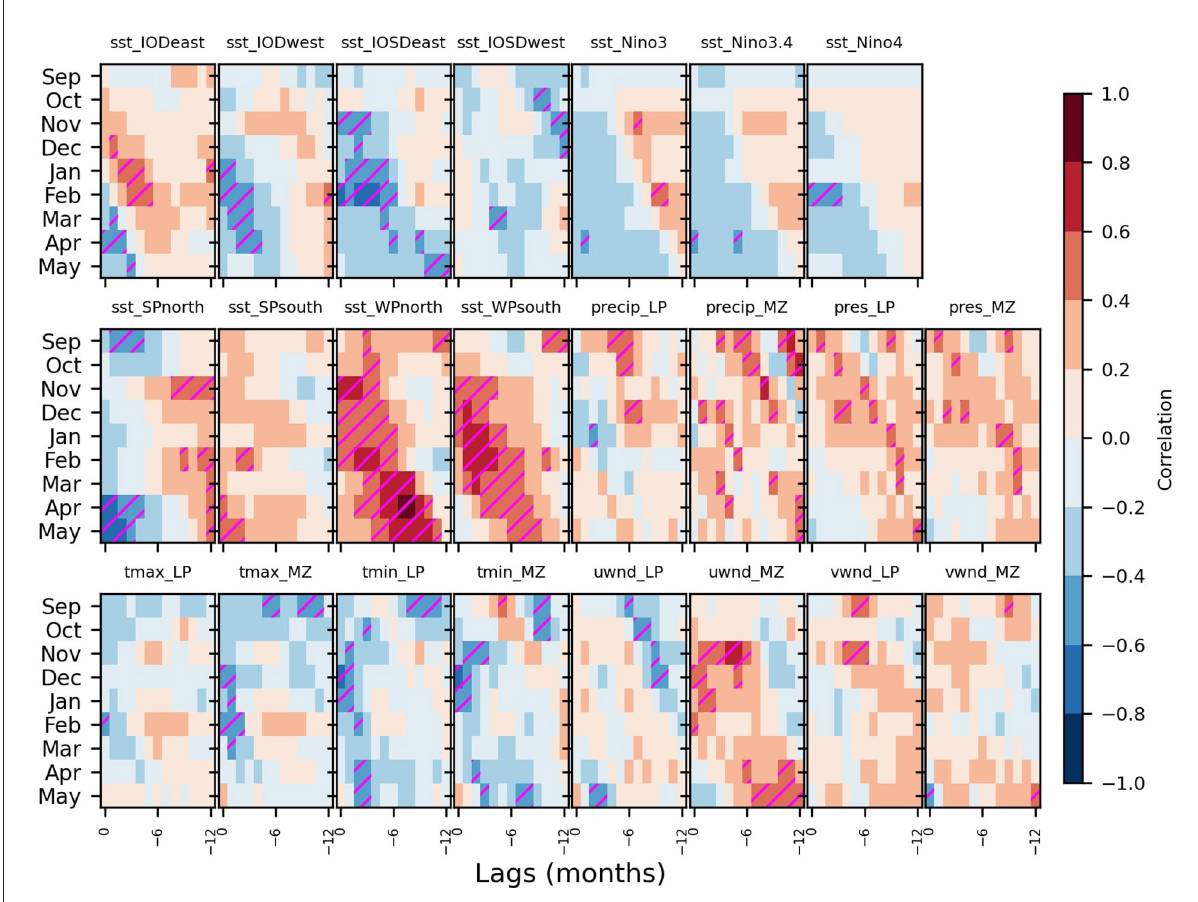
FIGURE4 The lagged relationship between climate indices and malaria incidence in South Africa. Correlations between climate indices and malaria incidences throughout the malaria season (y-axes) and lags (x-axes) are illustrated with color shadings. Correlations that are significant at the 5% significance level are hatched in magenta. They are reported for various climate indices indicated above each panel (listed in Supplementary Table 1). The sectors used for SST indices (IODwest, IODeast, IOSDwest, IOSDeast, Niño3, Niño3.4, Niño4, SPnorth, SPsouth, WPnorth, and WPsouth) and local indices (precip, pres, tmax, tmin, uwnd, and vwnd; with the subscripts LP and MZ if averaged over Limpopo or Mozambique, respectively) are illustrated in Supplementary Figure 1. Domain boundaries are indicated in Table